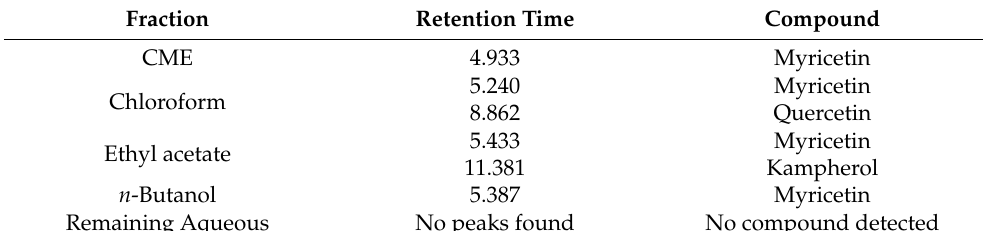
Table 2. HPLC profile of H. crispum total methanol extract (CME) as well as its various fractions.